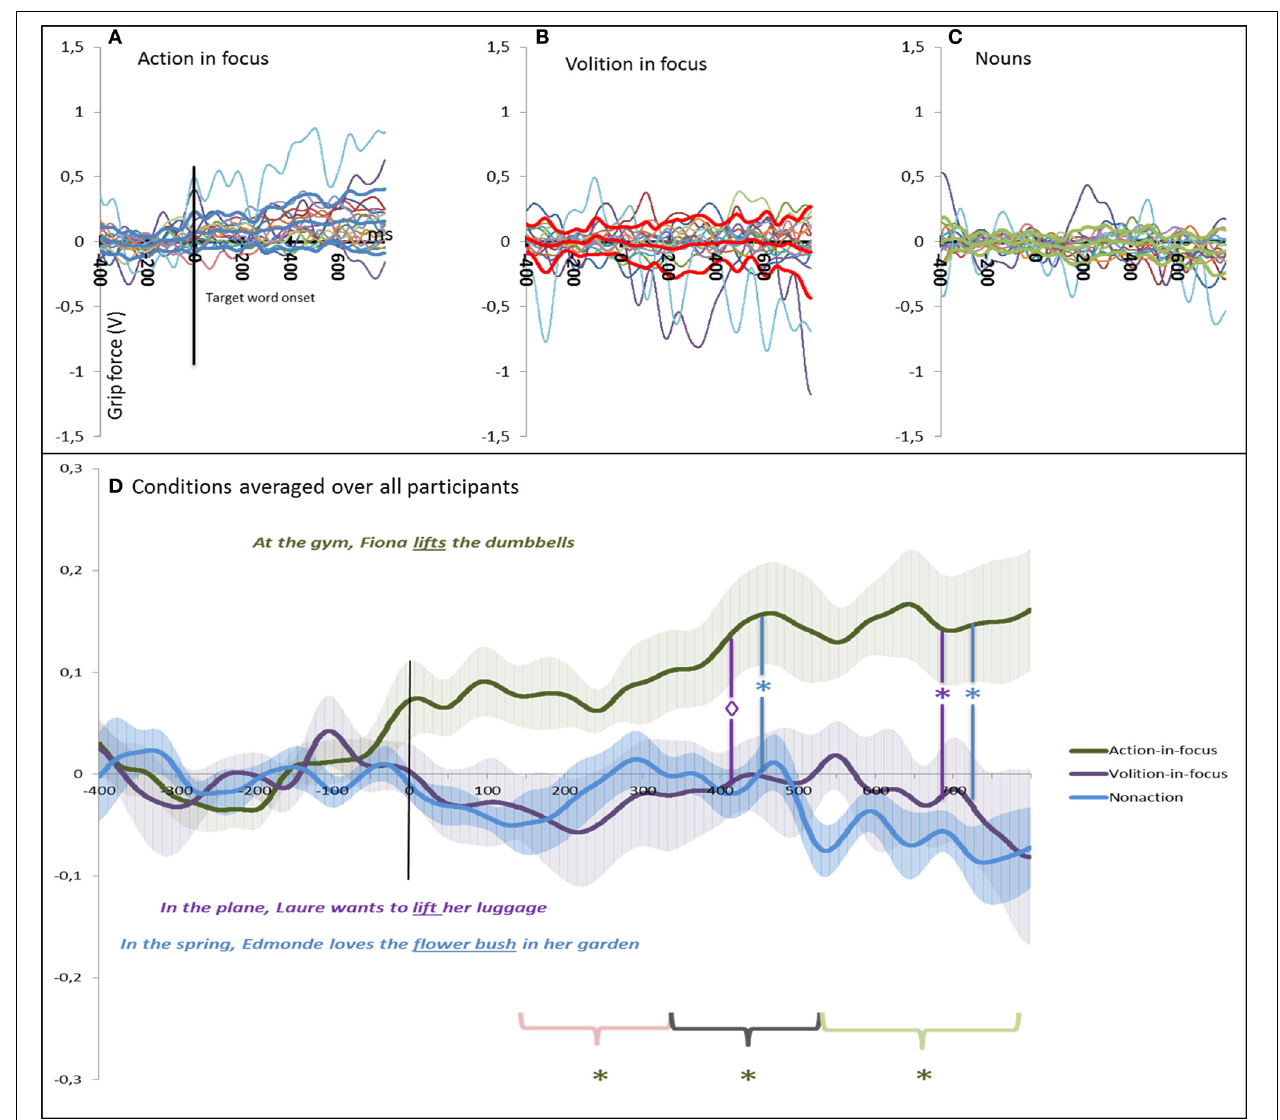
FIGURE 2 | Modulation of the grip-force amplitude as a function of time after target onset in Experiment 1 (Volition). (A–C) displays individual data for the three conditions (the bold lines represent the means and standard deviations) and (D) compares data of the three conditions averaged over all participants. In (D) we also show the standard error of the mean (s.e.m.) around the mean value across the subjects (shaded regions). For the